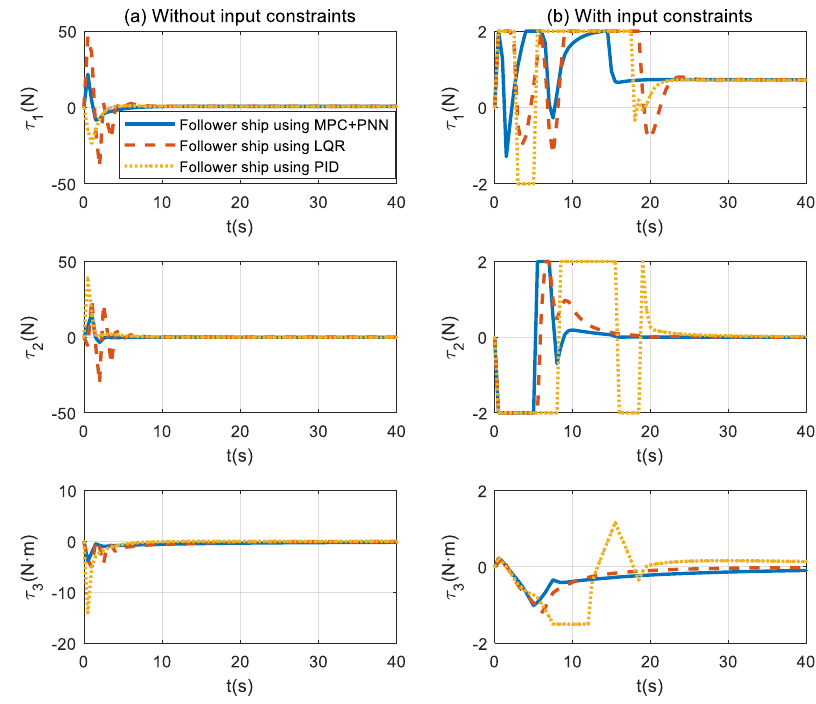
Figure 10. The responses of control inputs with and without input constraints.